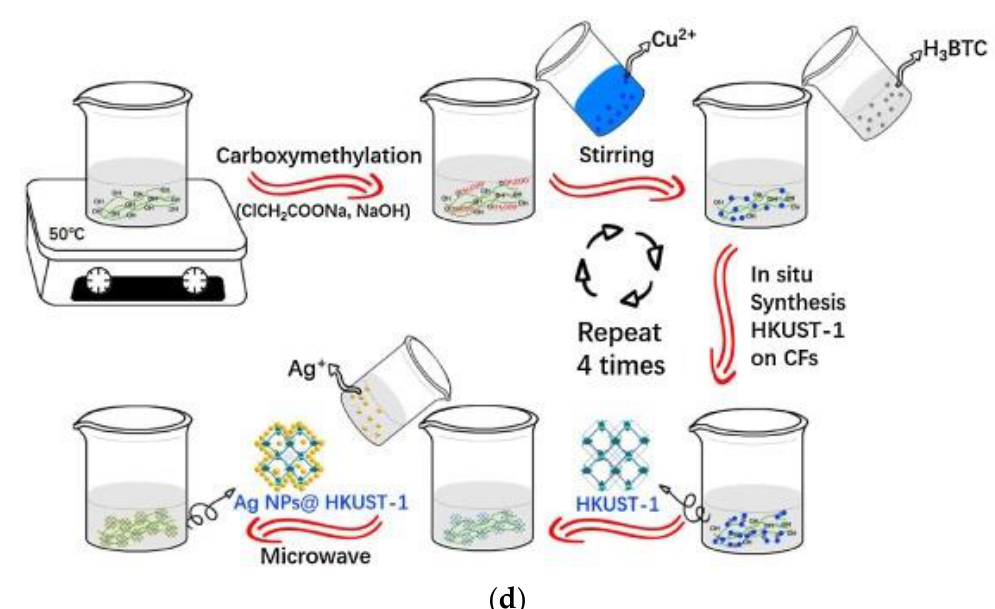
Figure 2. Examples of development of complex composite systems by various synthetic routes. ( a ) PEI–Ag + /PAA bilayer. Reduction of silver ions within PEI–Ag + /PAA films using freshly prepared NaBH 4 yielded an abundance of stable nanoparticles within the multilayered system (LBL). Reprinted with permission Nano Letters 2002, 2, 5, 497–501. Copyright 2002 American Chemical Society [83]. ( b ) Schematic diagram of CD-MOF template guided synthesis of AgNPs by solution impregnation, followed by reduction, cross-linking and GRGDS surface modification [84]. Copyright 2019 John Wiley and Sons. ( c ) Schematic illustration of preparation of porous chitosan–silver nanocomposite (PCSSNC) films [87]. Copyright 2010 Elsevier. ( d ) Schematic representation of the in situ preparation of AgNPs@ HKUST-1@ CFs composites [89]. Copyright 2018 Elsevier.